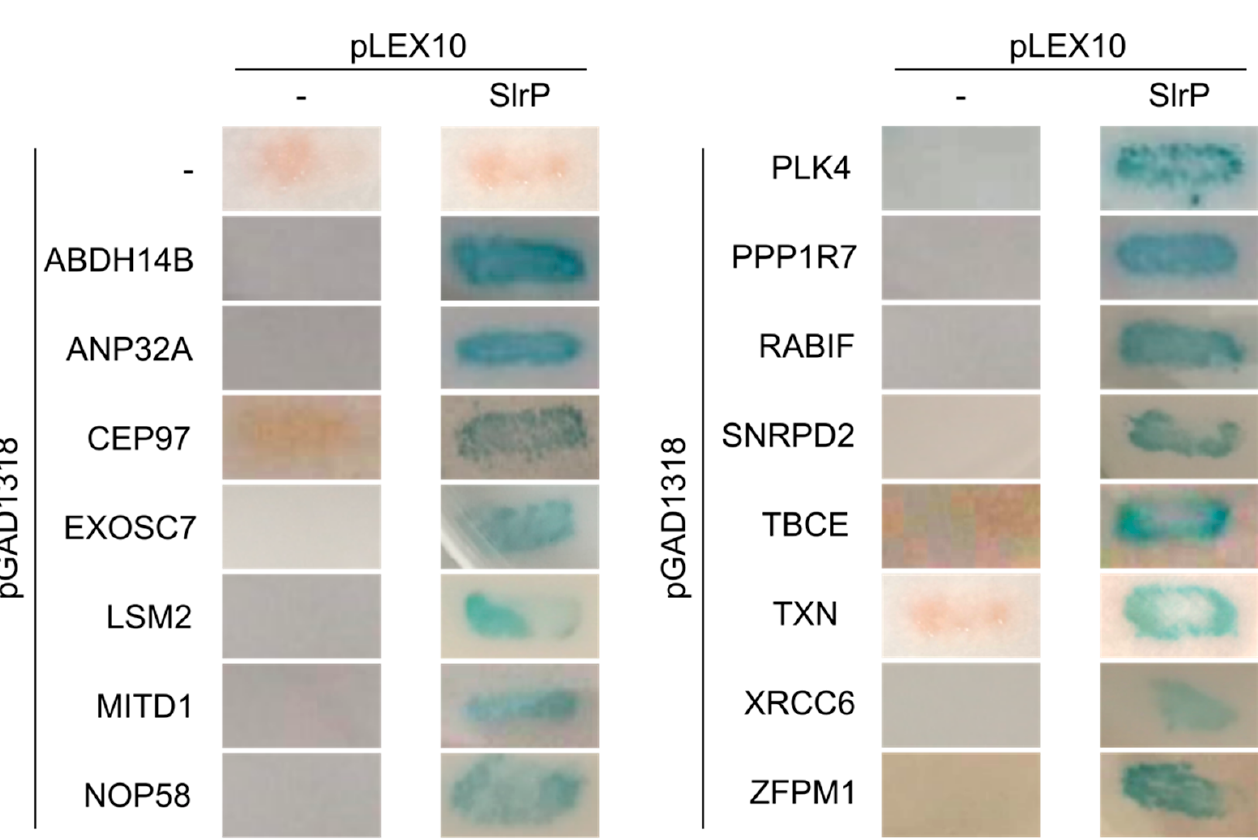
Figure 1. Analysis of interactions of SlrP with human proteins in the yeast two-hybrid system. De- rivatives of plasmid pGAD1318 expressing the indicated proteins (or C-terminal fragments of these proteins) were introduced in yeast strain L40 together with pLEX10 or pLEX10-SlrP. The interac- tion between SlrP and human proteins is shown by the detection of blue color in the presence of X-Gal after a β -galactosidase filter assay. Empty vectors were used as negative controls. Table 3. Candidate host partners of SlrP identified in a yeast two-hybrid screen.